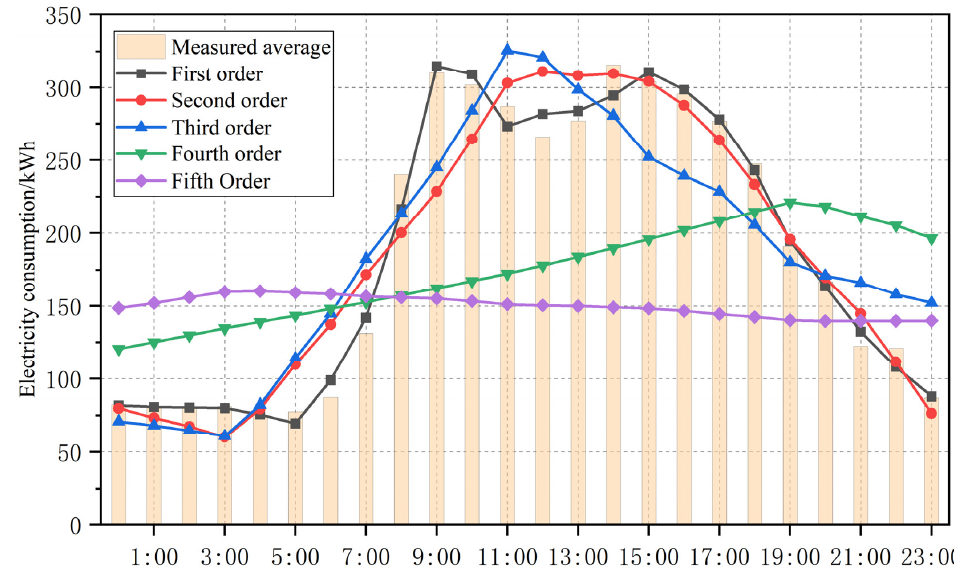
Figure 8. Comparison of wavelet transformed and reconstructed low-frequency signals with the original signals. Table 4. Correlation between low-frequency reconstructed signals of various orders and measured data.